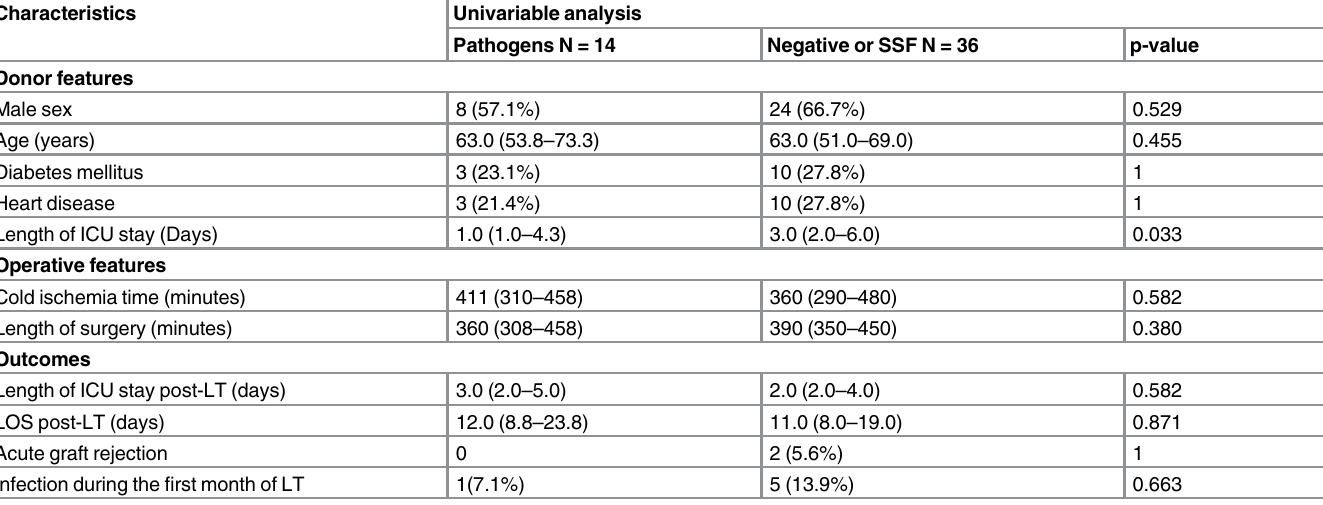
Table 4. Comparative analysis by the culture result from the preservation fluid just before implantation.